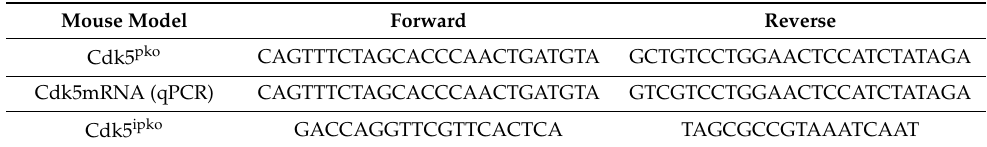
Table 1. Primer sequences for PCR